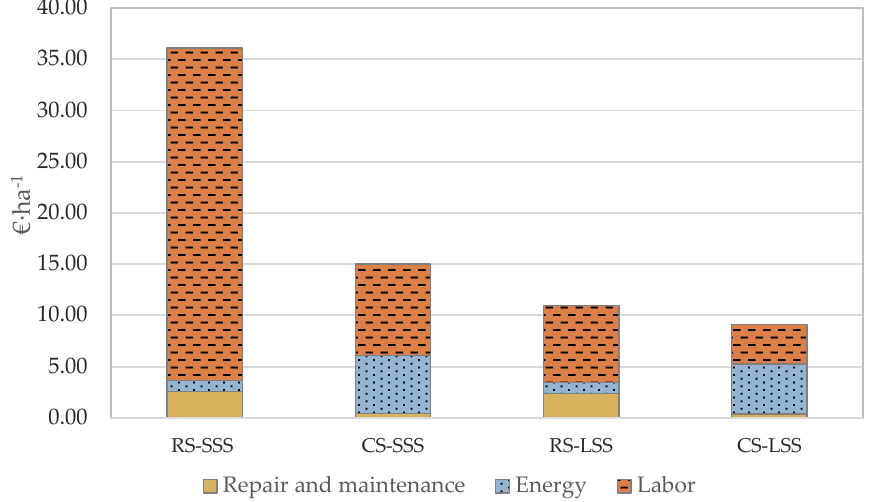
Figure 5. Operation cost per unit area analysis (RS—Robotic System; CS—Conventional System; SSS—Small-Scale Scenario; LSS—Large-Scale Scenario).